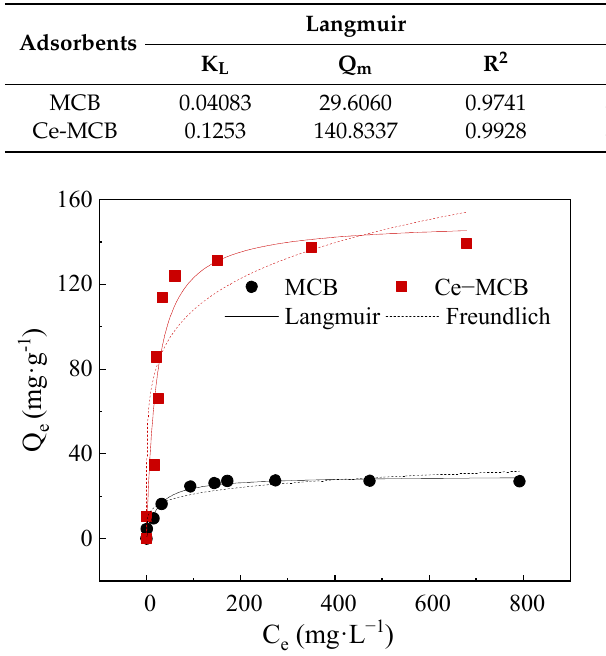
Figure 14. Absorption isotherm of Pb 2+ adsorbed on biochars.